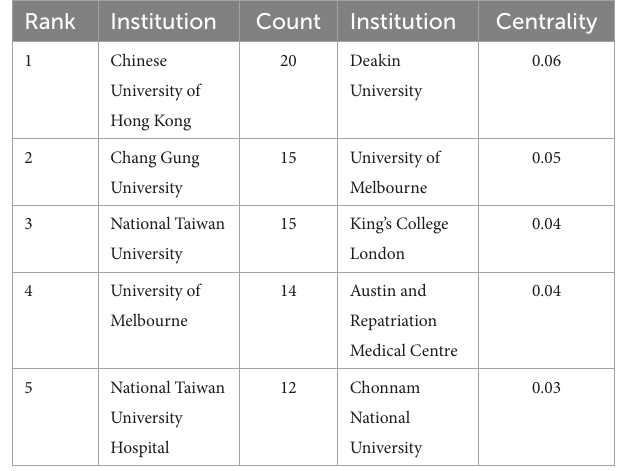
TABLE 8 Top five institutions in terms of count and